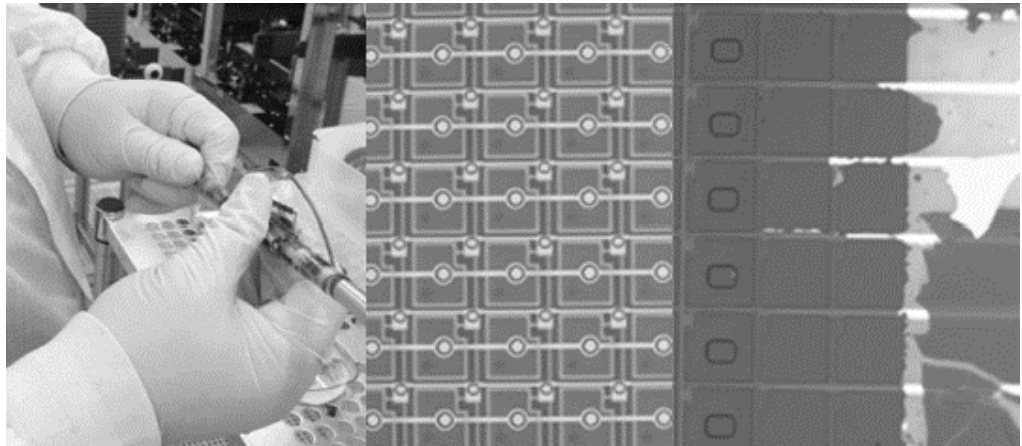
Figure 10. Flexible photodiode array wrapped around a 3/8” stainless steel pipe ( left ), microscope image of pixelated PIN diode structure ( center ), and full fill factor PIN diode structure ( right ) after wrapping around 3/8” stainless pipe.